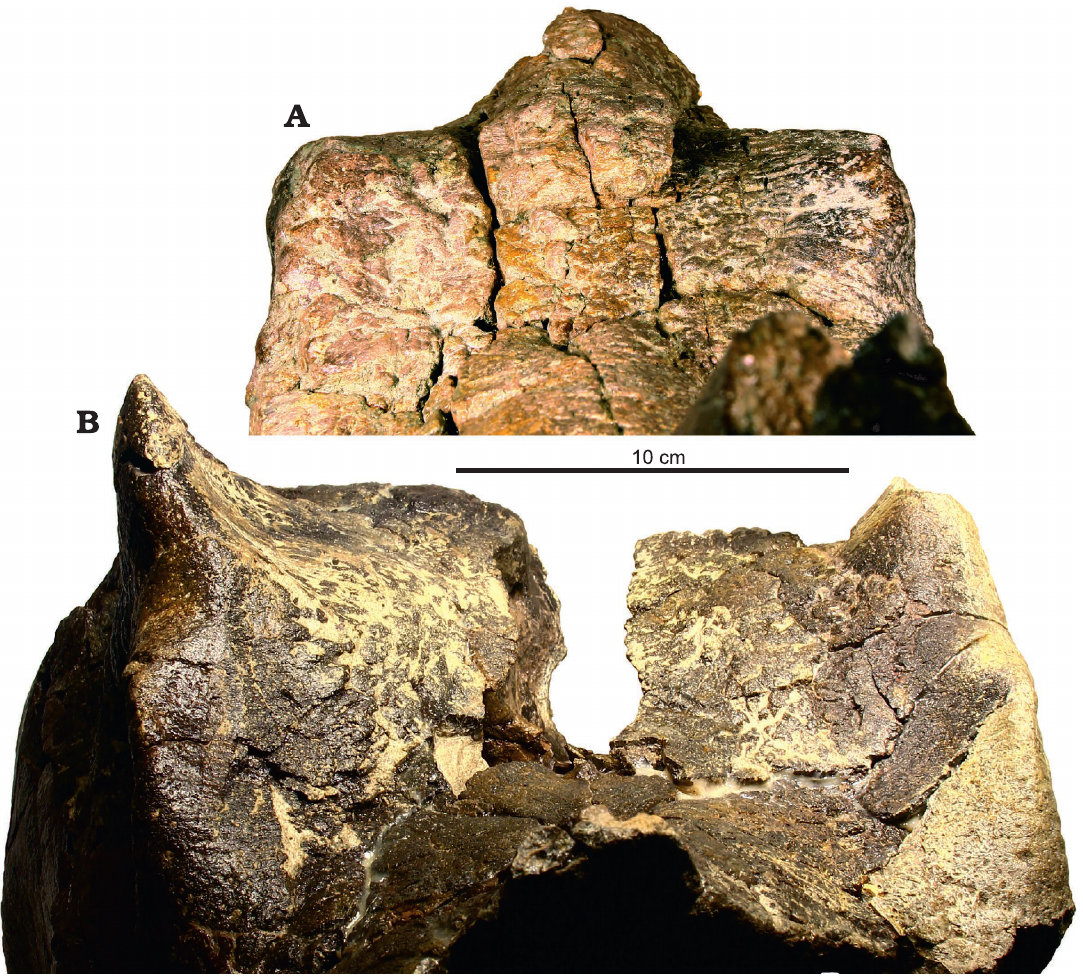
Fig. 4. Anterior views of supraorbital ornamentation of Einiosaurus procurvicornis Sampson, 1995, MOR 456 8-8-87-1 ( A ) and eucentrosauran ( Einiosaurus procurvicornis or Achelousaurus horneri Sampson, 1995), MOR 591 ( B ), from the Campanian Two Medicine Formation, Montana,